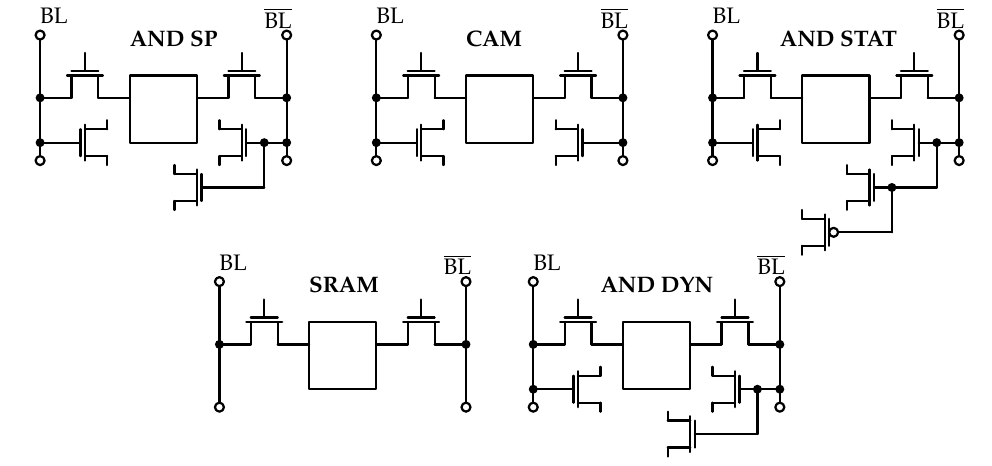
Figure 20. The transistor load on bitlines for each cell